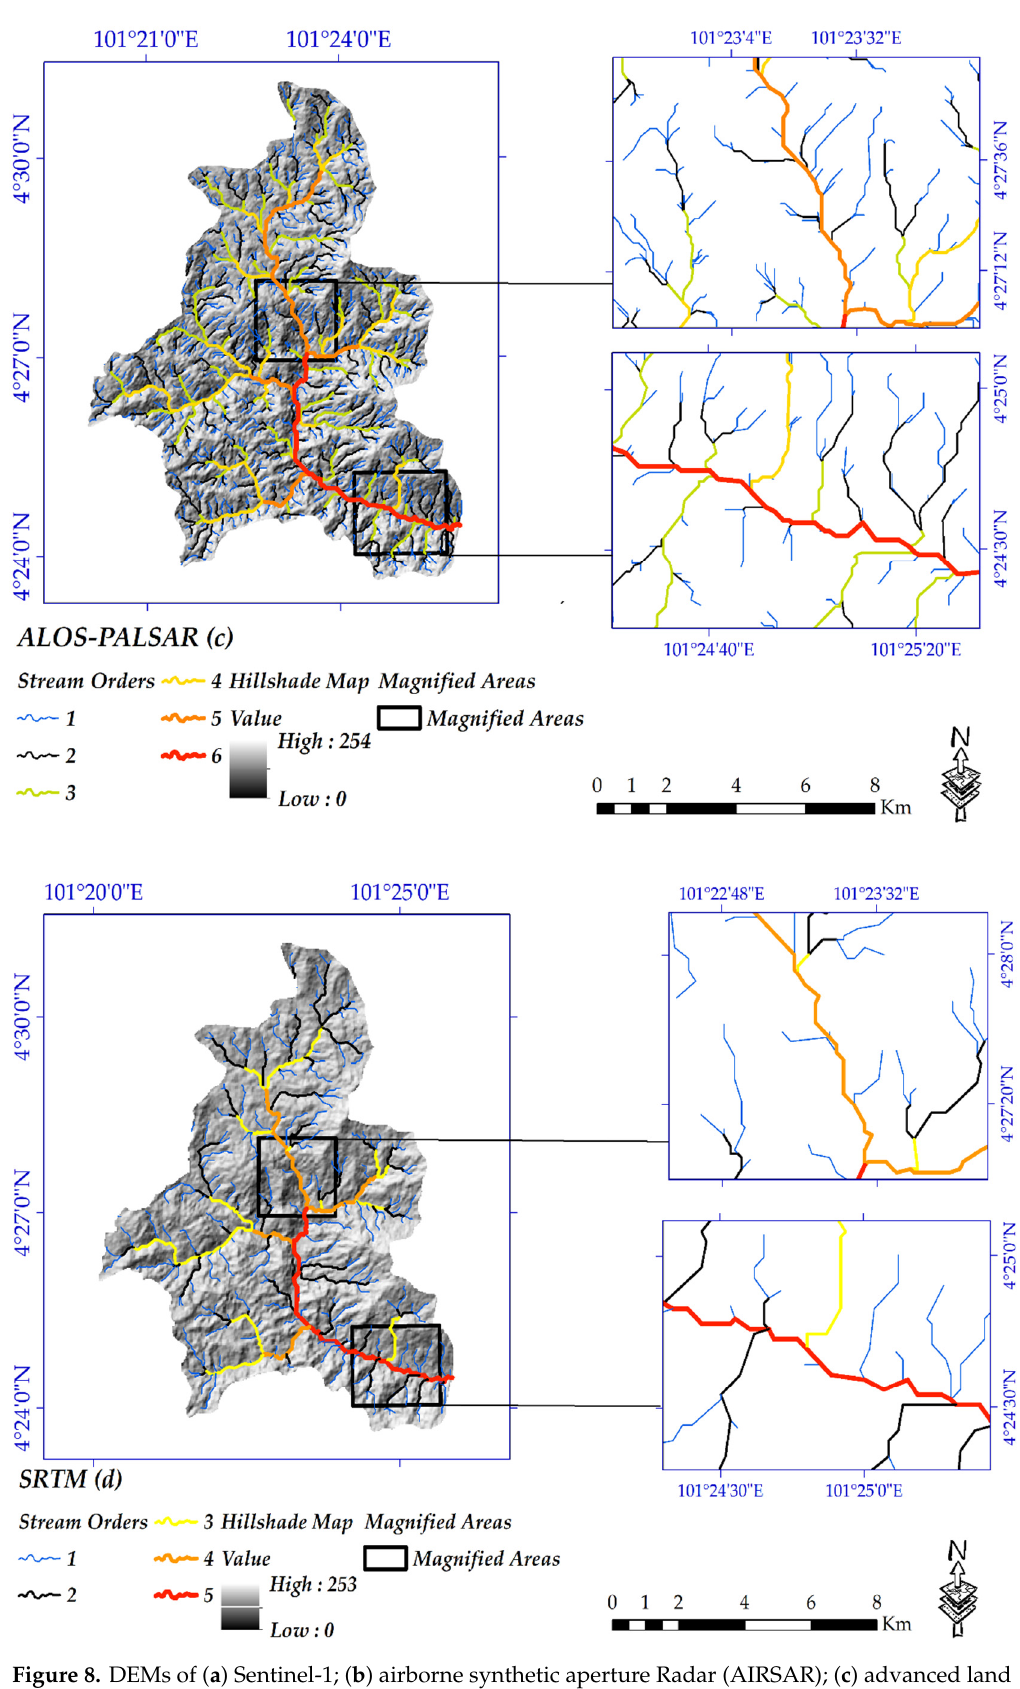
Figure 8. DEMs of ( a ) Sentinel-1; ( b ) airborne synthetic aperture Radar (AIRSAR); ( c ) advanced land observing satellite phase array L-band synthetic aperture radar (ALOS-PALSAR); and ( d ) SRTM.